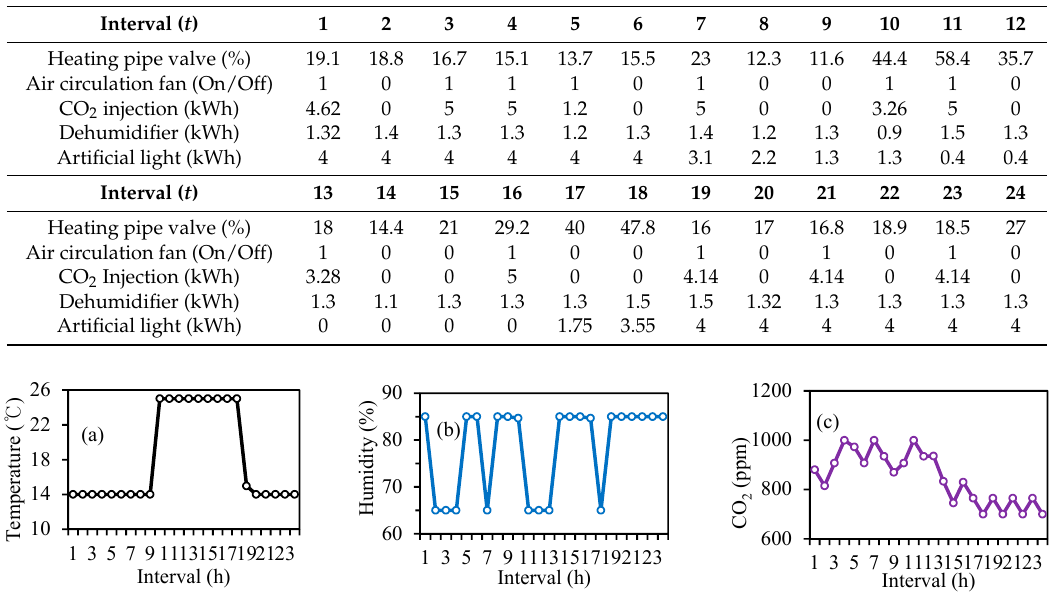
Table 6. Equipment usage for environment control during winter season in greenhouse.